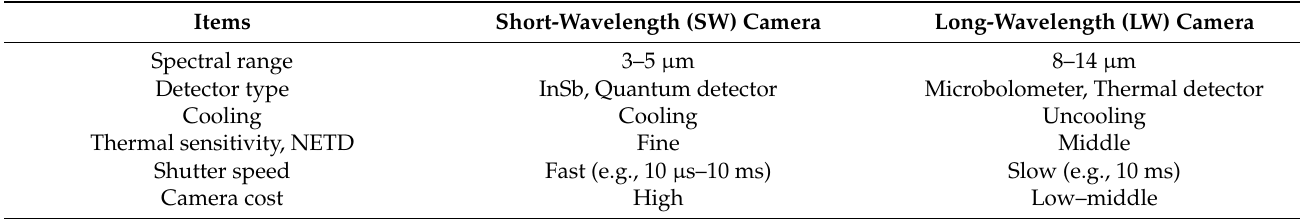
Table 5. Characteristics of types of IR